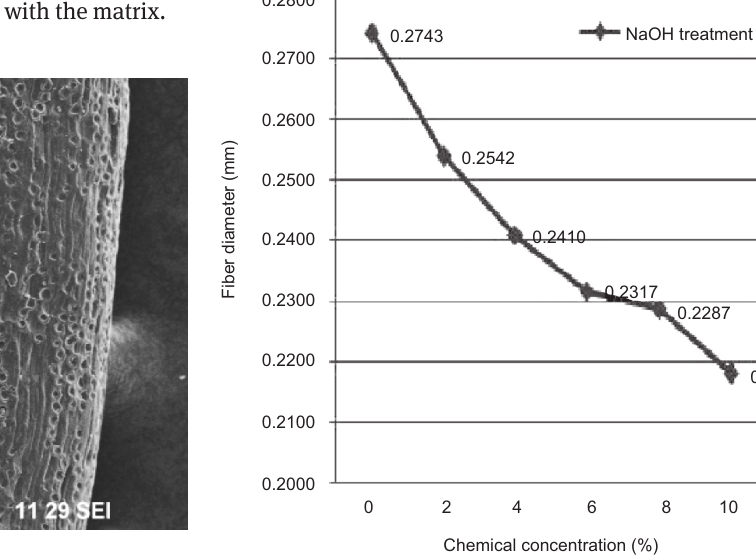
Figure 5 Surface appearance of the coir fiber after 4% NaOH treatment.